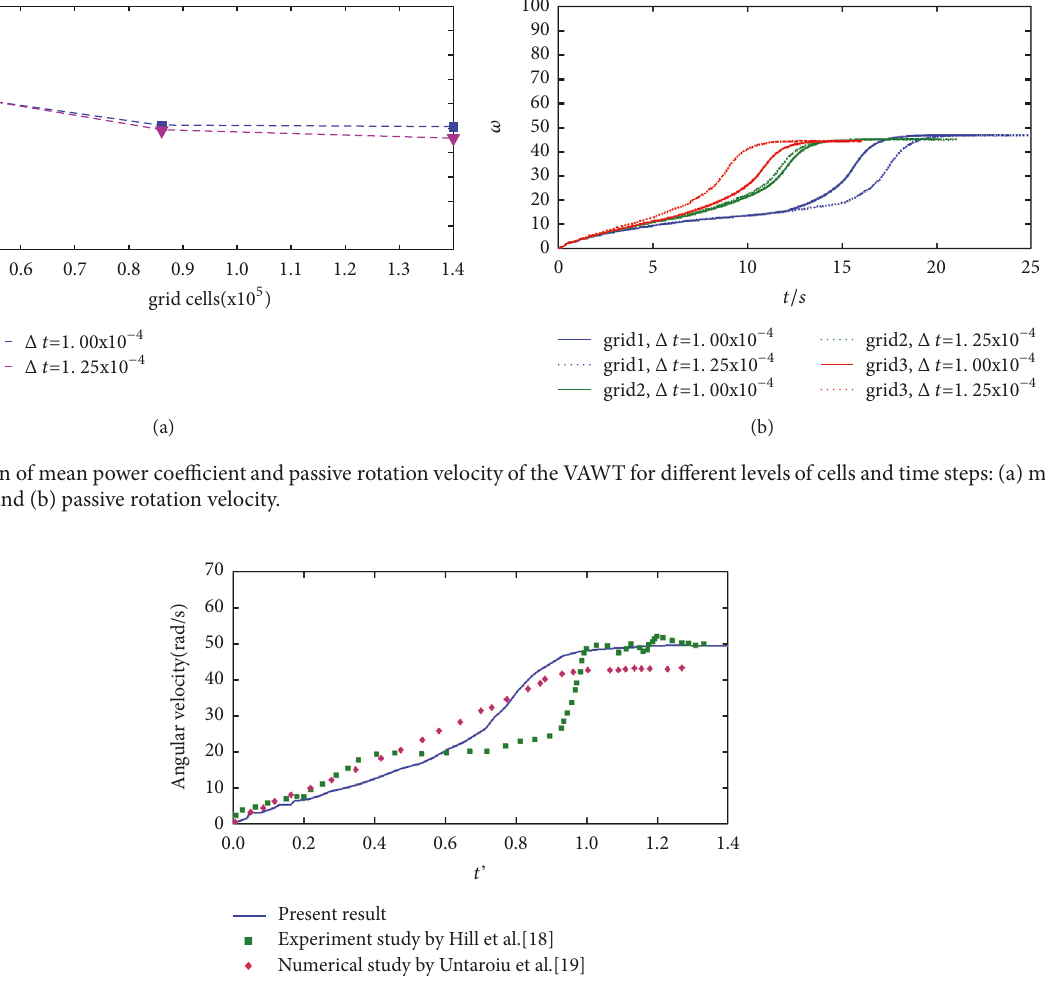
Figure 4: Time variation of the passive rotation velocity of the VAWT.